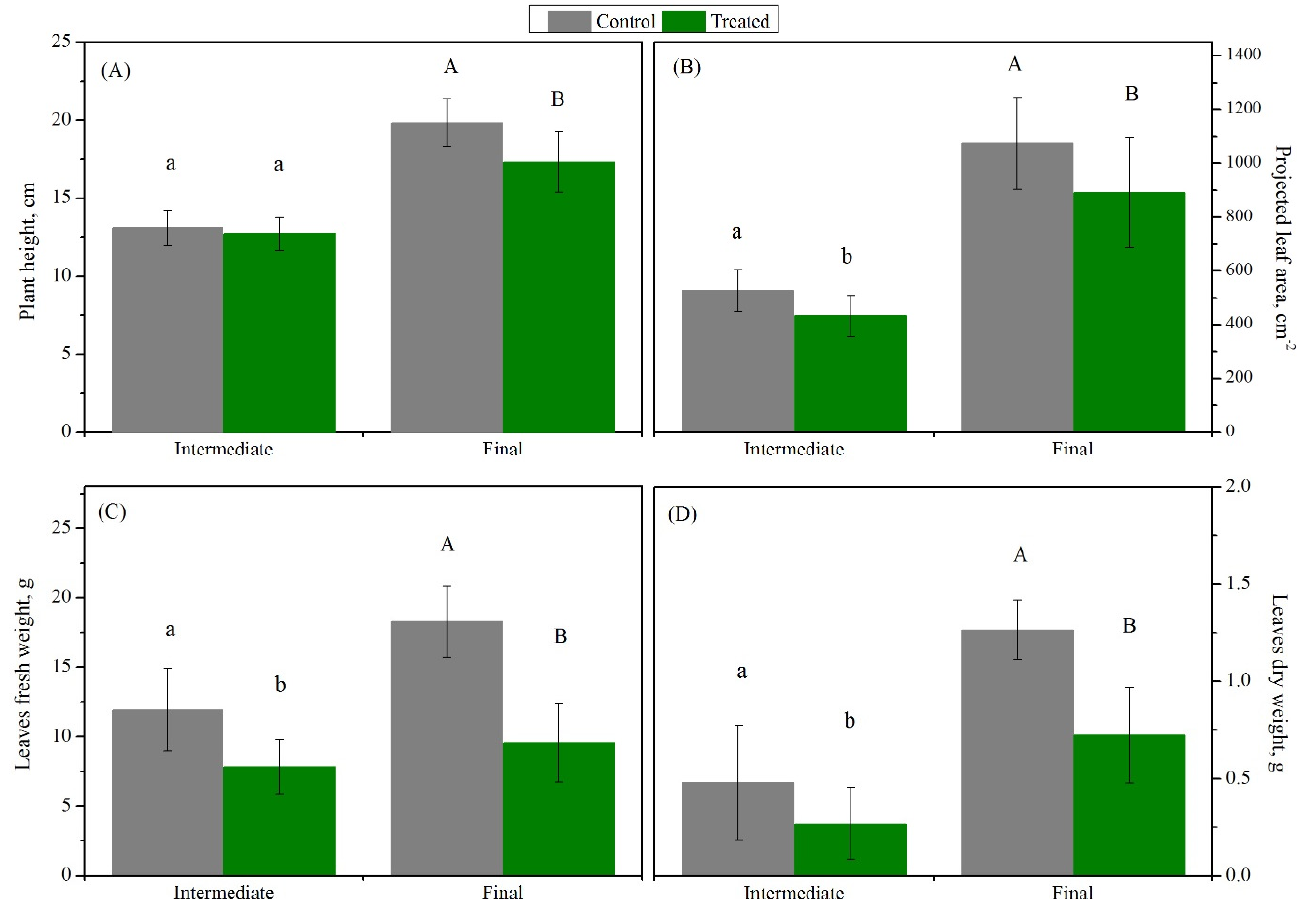
Figure 5. Growth characteristics of basil leaves grown as a secondary crop in the second experiment: plant height ( A ), projected leaf area ( B ), leaves fresh weight ( C ), and leaves biomass ( D ) at the intermediate and final harvests. Values are expressed as mean ± standard deviation ( n = 50 for plant height and n = 10 for all the others). Different letters indicate statistically significant differences between treatments at each harvest (small letters refer to the intermediate and capital ones to the final harvest, p <